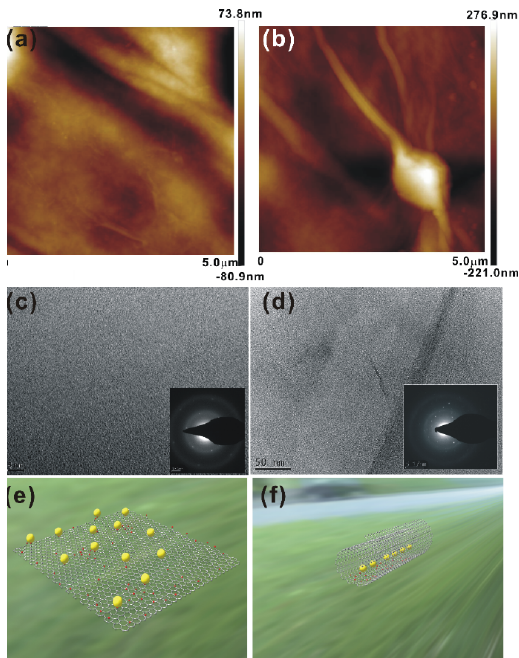
Figure 2. ( a , b ) AFM images; and ( c , d ) TEM images of GO and GNP1 films, respectively: The inset figures in ( c , d ) show the corresponding SAED patterns; and ( e , f ) show schematic diagrams of phosphor particles attached to GO sheets and completely scrolled sheets, respectively.